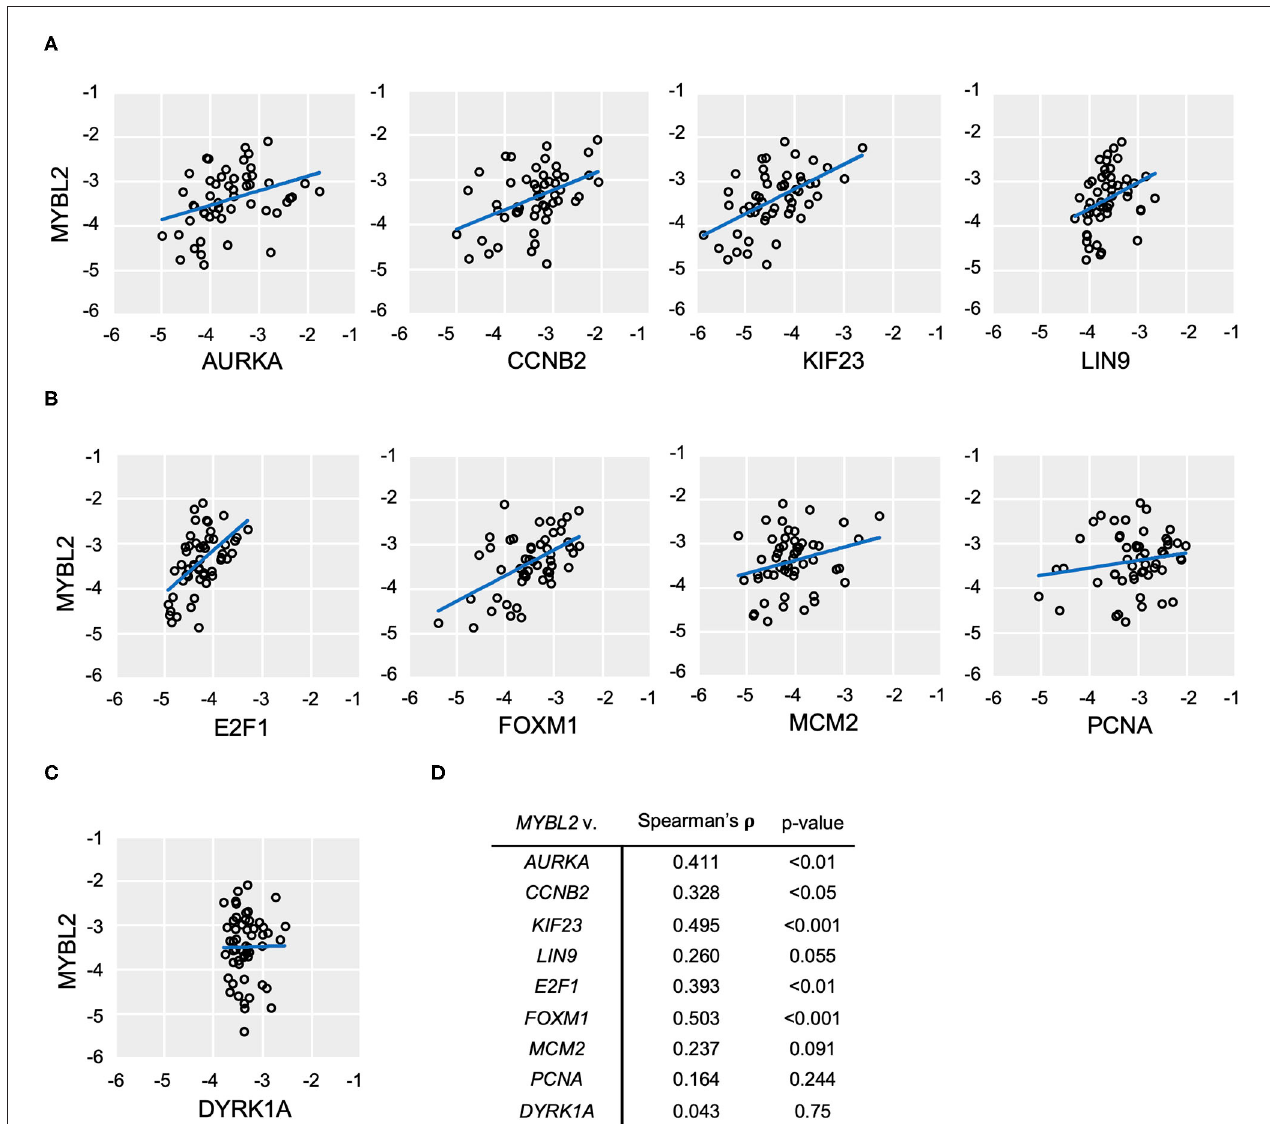
FIGURE 5 | MYBL2 expression correlates with DREAM target gene expression. (A–C) RT-qPCR analysis of human ovarian tumor surgical sections ( N = 52). As in Figure 4 , expression of DREAM (A) and DREAM/MMB (B) target genes is shown relative to that of MYBL2 as well as non-DREAM/MMB target, DYRK1A . Plots show log 10 mRNA expression relative to 18S ribosomal RNA housekeeping control. (C) Non-parametric Spearman Rank Correlations were used for analysis. (D) Results of non-parametric Spearman’s rho and associated p